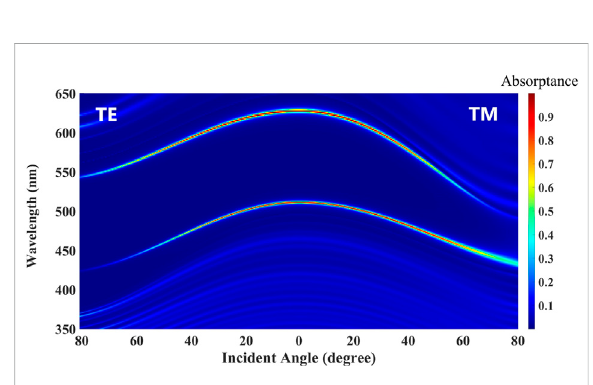
FIGURE 4 Simulated intensities of the electric fi eld at absorptionwavelengthsof510.77 nm (A) and627.06 nm (B) forthePC (AB) M D(BA) N . All parameters are the same as those used in Figure 2C.